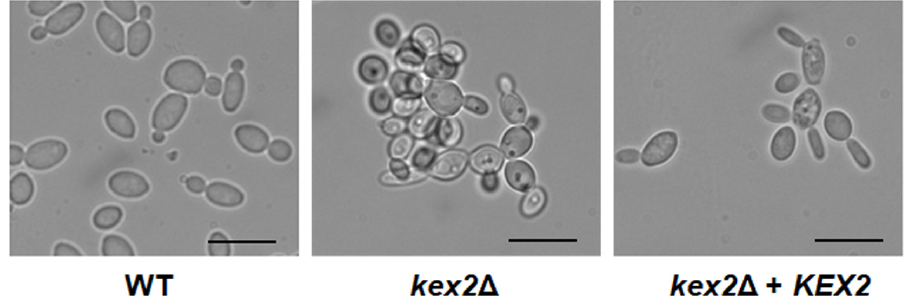
Figure 1. Cell morphology of Candida albicans kex2 Δ null mutant. Cells were grown at 28 °C for 15 h in Sabouraud medium, demonstrating cell aggregates in the null mutant strain. Scale bar, 10 μ m. Strains used are NGY152 (WT), HMY209 ( kex2 Δ ), and HMY210 ( kex2 Δ + KEX2 ). used are NGY152 (WT), HMY209 ( kex2 ∆ ), and HMY210 ( kex2 ∆ + KEX2